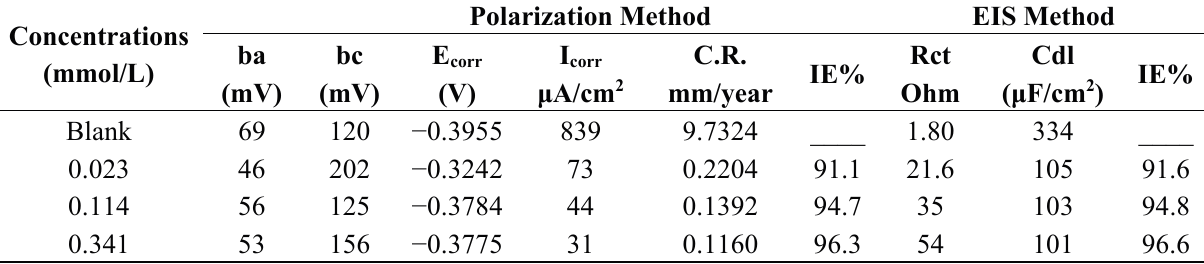
Table 3. Inhibition efficiency values of steel electrode in 1 M HCl containing various concentrations of the OA-TS calculated by polarization and EIS methods.